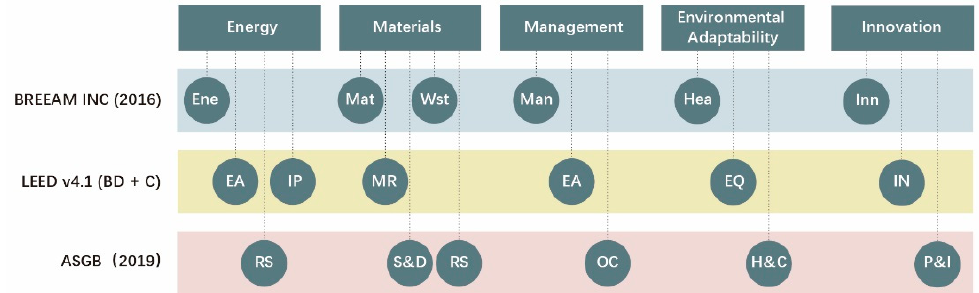
Figure 2. Scopes of related indicators.